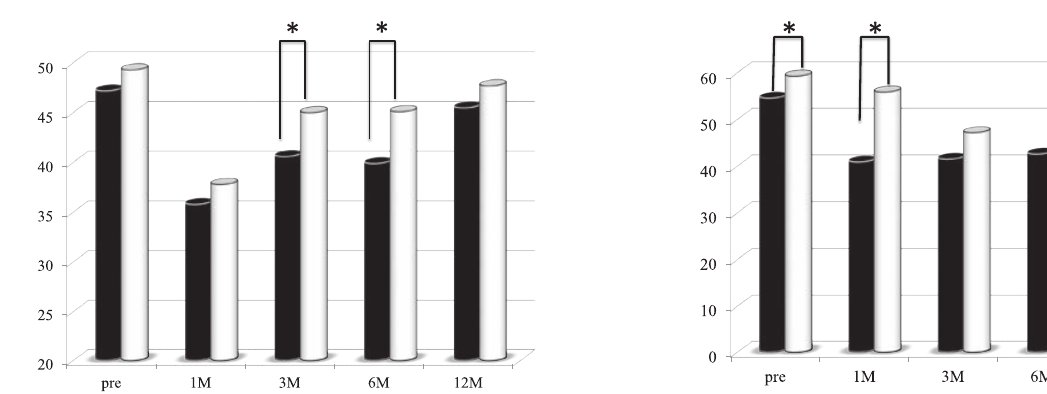
Figure 6 Changes in the liver computed tomography values of the patients who underwent pancreaticoduodenectomy in the first period (with low-titer digestive enzyme preparations) versus the second period (with high-titer pancrelipase) The liver computed tomography values before surgery and at 1 month postoperatively were significantly lower in the first period group (black bar) than in the second period group (white bar).